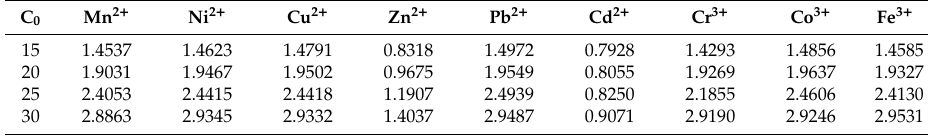
Table 3. The sorption capacity of the SAP against di ff erent concentrations of the heavy metal